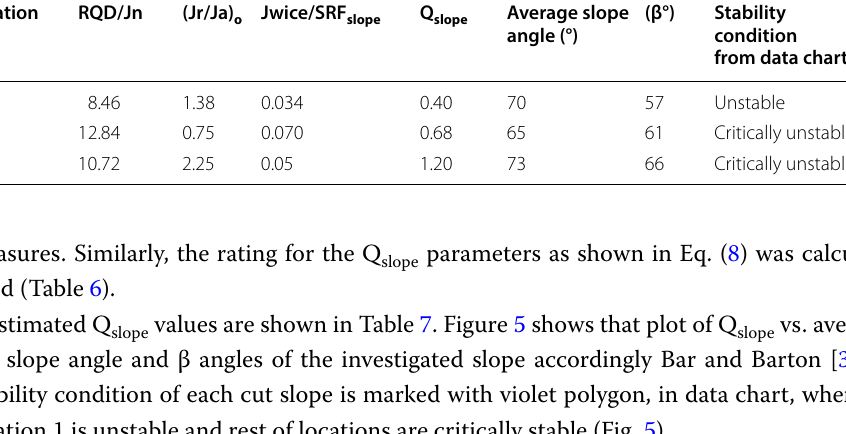
Table 7 Estimated Q value and slope angle of all locations and their stability condition slope Location